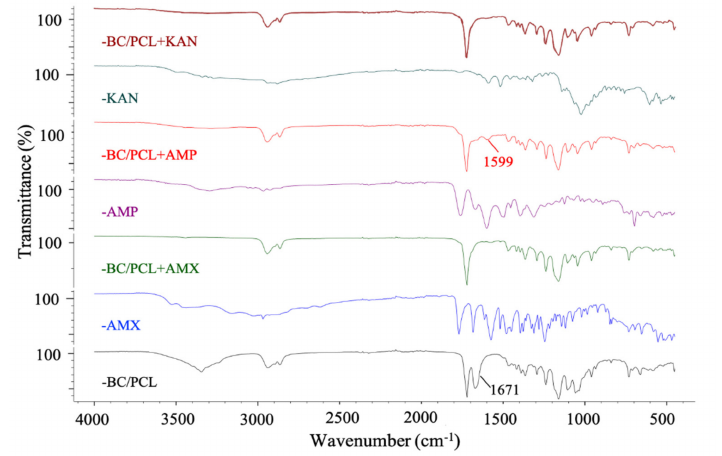
Figure 4. FTIR spectra of EHD-3D printed